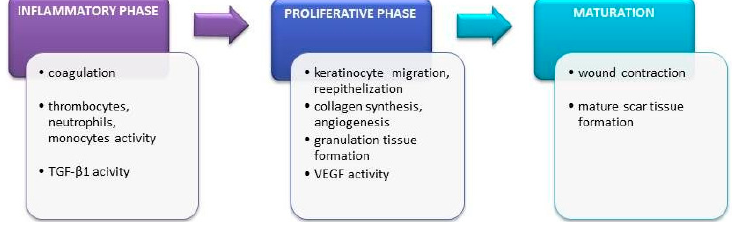
Figure 10. The process of wound healing.